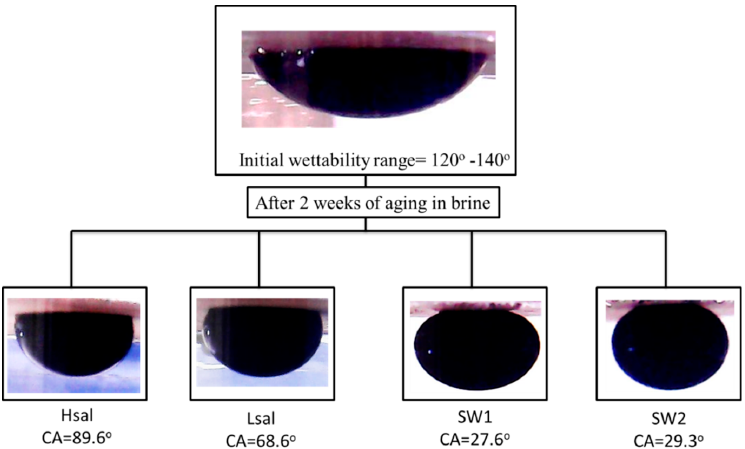
Figure 11. Sample images of pendant oil drops during CA measurements of Case 4 (oil wet) calcite samples in crude oil and treated with different brines for two weeks.